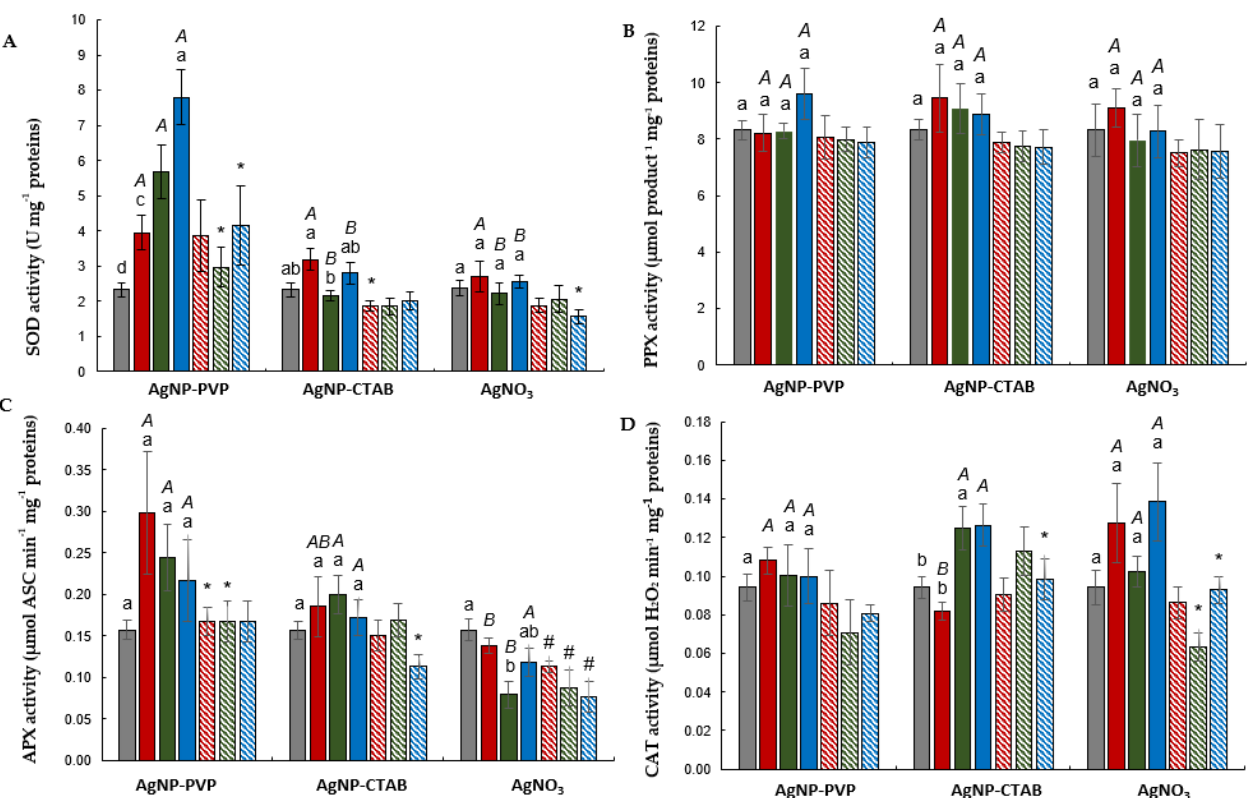
Figure 1. Activites of antioxidative enzymes ( A ) superoxide dismutase (SOD), ( B ) pyrogallol per- oxidase (PPX), ( C ) ascorbate peroxidase (APX), and ( D ) catalase (CAT) in roots of tobacco plants 7 days after exposure to 25, 50, and 100 µ M AgNP–PVP, AgNP–CTAB, and AgNO 3 , applied either alone or in combination with 125, 250, and 500 µ M cysteine (cys). Values are the means ± SE of three biological replicates, each with six technical replicas. If columns are marked with different letters, the treatments are significantly different at p ≤ 0.05 (a two-way ANOVA followed by Duncan’s post hoc test); small letters mark the differences among different concentrations of the same treatment type as well as control; capital letters mark the differences among different treatment types of the same concentration; asterisk (*) denotes significant differences among treatments with and without cysteine of the corresponding concentration, while hash sign (#) denotes significant difference between each treatment with cysteine and